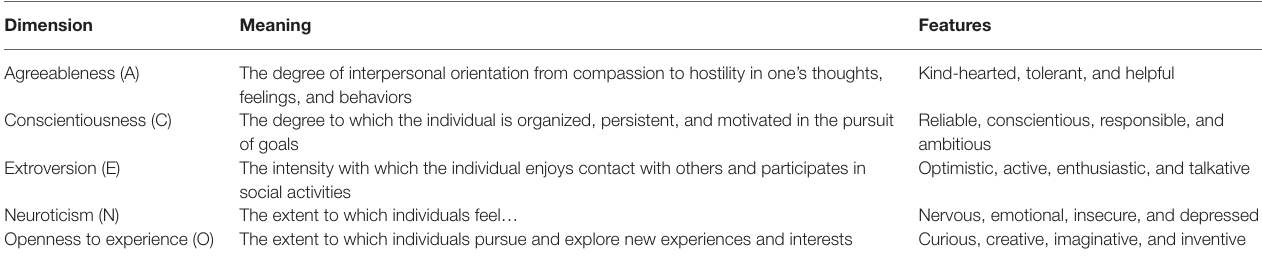
TABLE 1 | Description of the five personality traits (John et al., 2008).